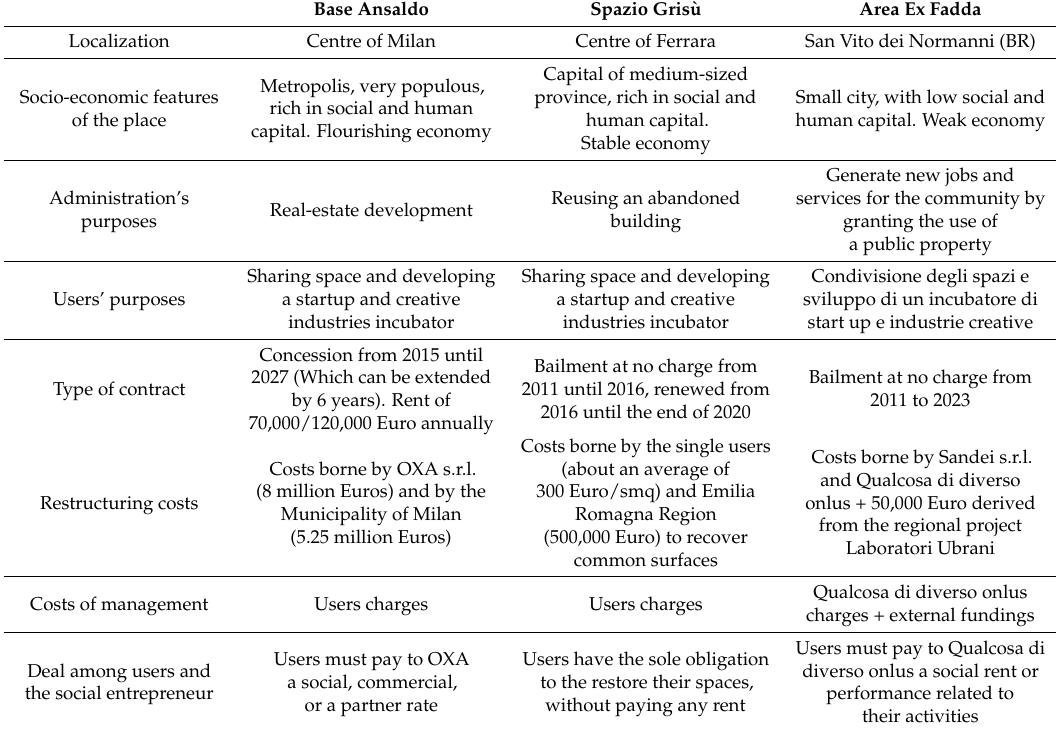
Table 4. Interpretative and comparative table of the bottom-up enhancement processes started in the former fire station in Ferrara, Base Ansaldo, and Ex Area